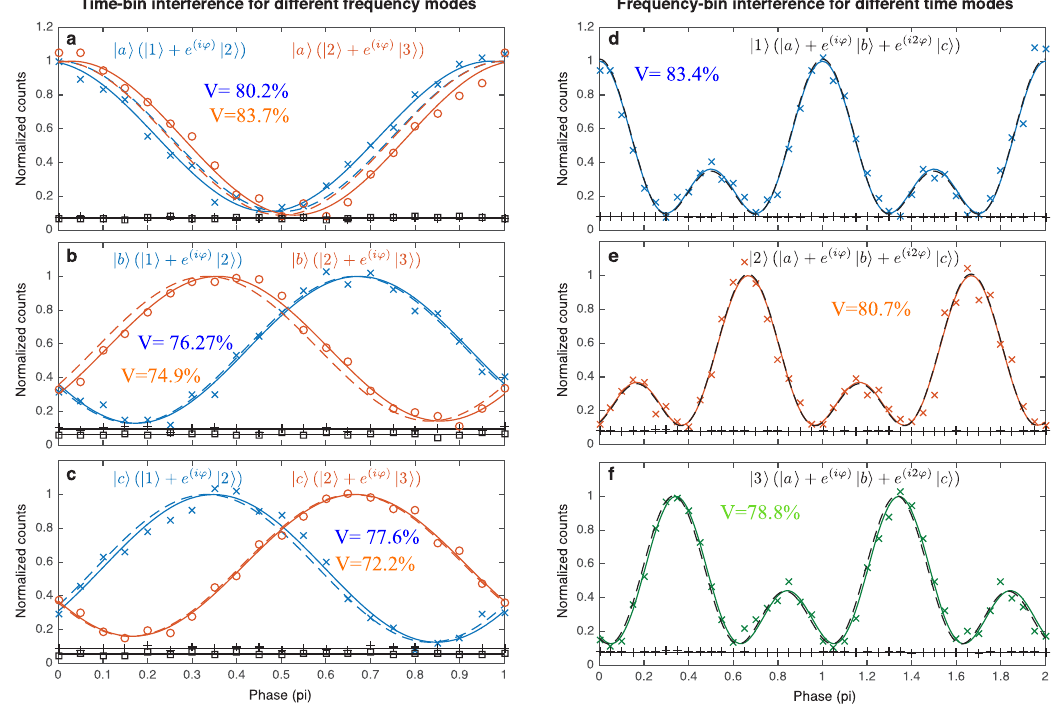
Figure5: Quantuminterferencemeasurementsperformedforone-wayquantumoperations.(a – c)illustratetheresultsobtainedfromtime-bin interference, while (d – f) depicts the results obtained from frequency-bin interference. Each pattern is reported together with the visibility measured from each projection. All the obtained visibilities exceed the thresholds necessary to violate their respective Bell inequalities (i.e., 70.7% for time-projections and 77.4% for frequency-projections). Adapted from